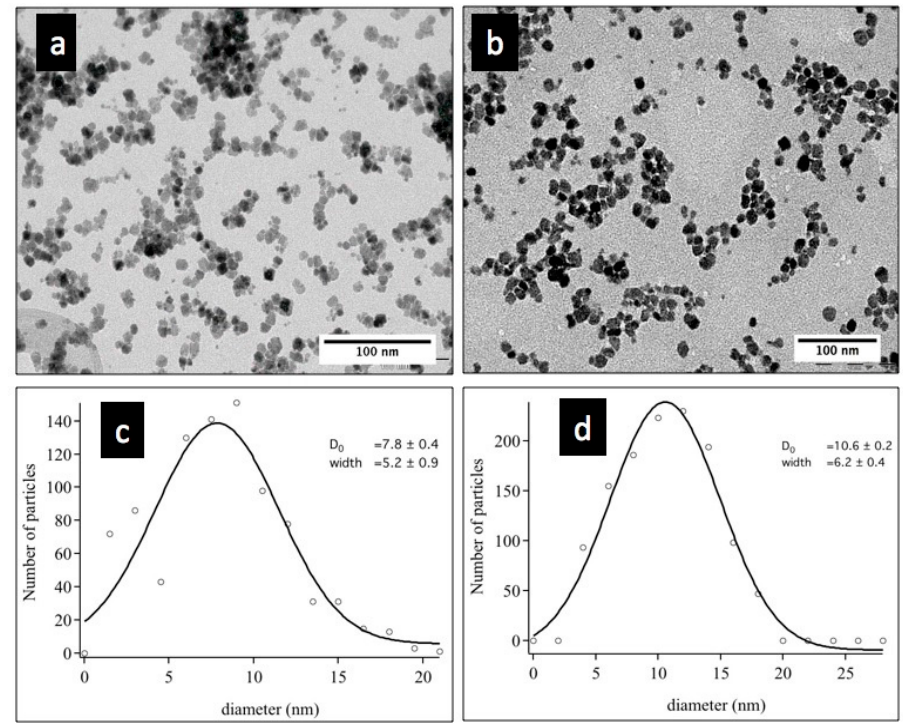
Figure 1. Transmission electron microscope (TEM) images of PAA-CeO 2 ( a ) and PAA-Fe 2 O 3 ( b ) nanoparticles. Statistical analysis of TEM images to determine the mean diameter of PAA-CeO 2 ( c ) and PAA-Fe 2 O 3 ( d ) with a Gaussian fit.